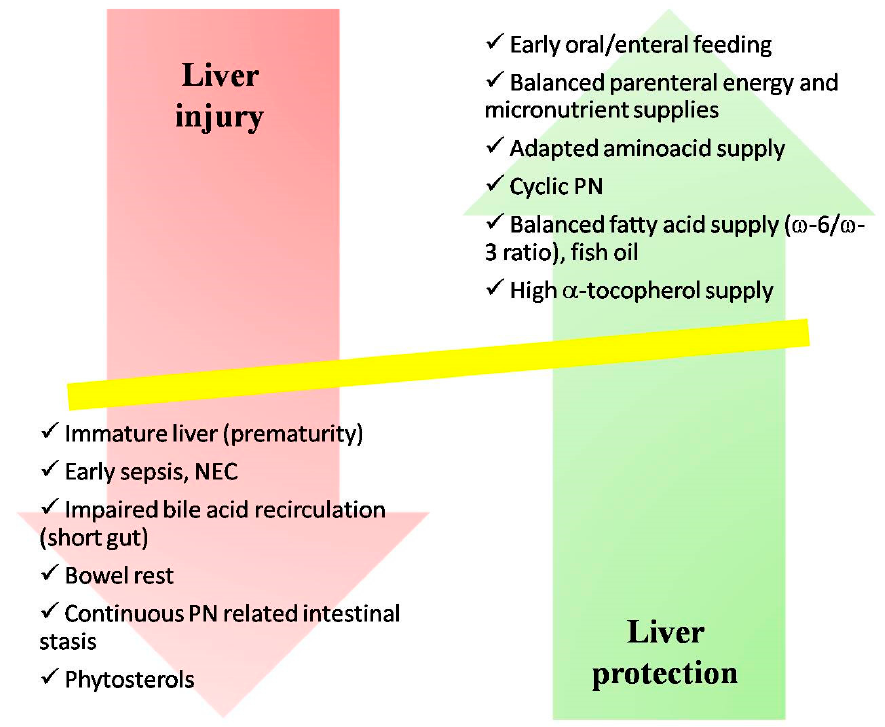
Figure 1. Factors affecting intestinal failure-associated liver disease. PN: parenteral nutrition, NEC: necrotizing enterocololitis.